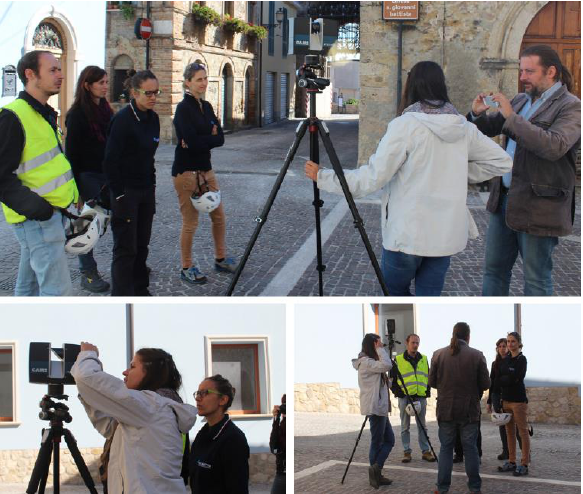
Figure 2 . University of Pavia and EUCENTRE researchers during on-site activities of survey and documentation in 2019